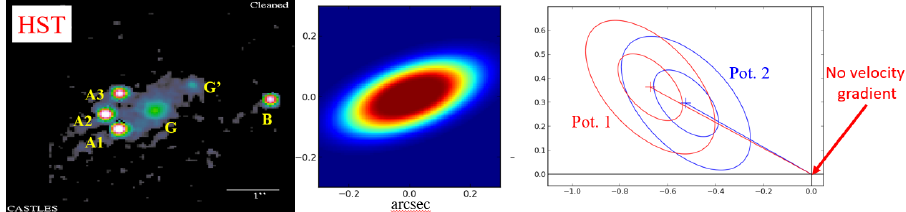
Fig. 2 Left: RX J0911 observed by the Huble Space Telescope. Centre: the gas component revealing ellipticity. Right: Evidence for